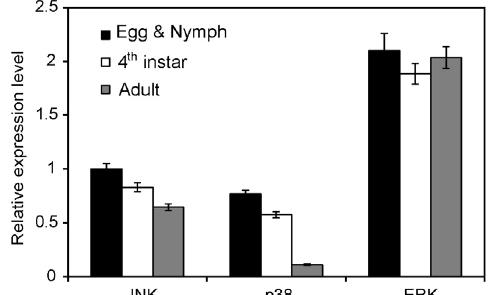
Figure 4. Quantification of JNK gene expression at different developmental stages. Each symbol and vertical bar represents the mean ± SD ( n =